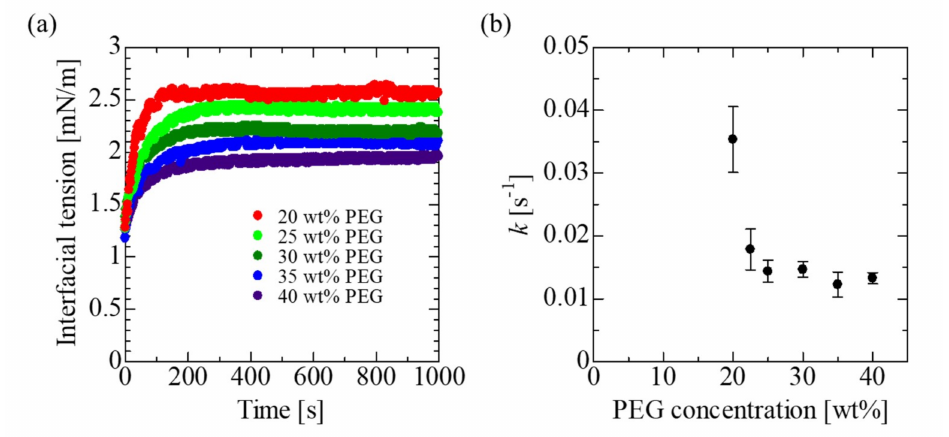
Figure 9. ( a ) Time evolution of the interfacial tension between PEG solutions and 20 wt % Na 2 SO 4 solution; ( b ) the phase separation rate constant, k , of ( a